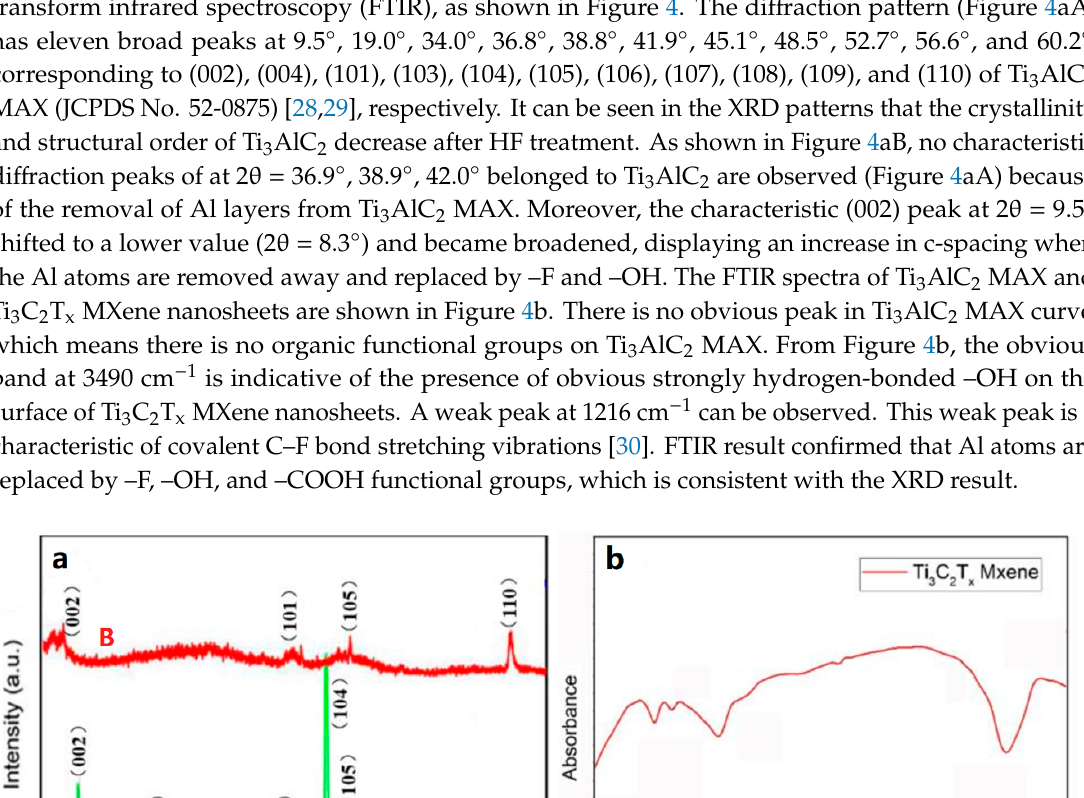
Figure 5. ( a ) TEM image of Ti 3 C 2 T x nanosheets, ( b ) HRTEM image of Ti 3 C 2 T x nanosheets, and ( c ) selected-area electron diffraction (SAED) of Ti 3 C 2 T x nanosheets. 3.2. The Structure of EP/Ti 3 C 2 T x MXene Nanosheets ECAs Figure 6 shows XRD patterns of the epoxy (a), Ti 3 C 2 T x MXene nanosheets (b), EP/Ti 3 C 2 T x MXene nanosheets composite containing 0.4 wt % Ti 3 C 2 T x (c), EP/Ti 3 C 2 T x MXene nanosheets composite containing 1.0 wt % Ti 3 C 2 T x (d), and EP/Ti 3 C 2 T x MXene nanosheets composite containing 1.6 wt % Ti 3 C 2 T x (e). The epoxy has a broad peak at 2 θ = 16.8°, whereas Ti 3 C 2 T x MXene nanosheets have peaks at 2 θ = 8.8°, 60.2° belonged to (002) and (110) planes. For EP/Ti 3 C 2 T x MXene nanosheets composite, the characteristic (002) peak of Ti 3 C 2 T x MXene nanosheets shifted to a lower value. The EP composite containing 0.4 wt % filler did not give any discernible (002) or (110) peaks (Figure 6c), most likely because the Ti 3 C 2 T x loading was not sufficient to yield any signal. At a higher loading fraction of 1.0 wt %, the composite had the (110) peak and also a similar (002) peak shift. The EP composite containing 1.6 wt % still had the (110) peak which become broad. Explanation for this might be that EP polymer molecular chains are incorporated in the Ti 3 C 2 T x MXene layers which make the d-spacing increase.